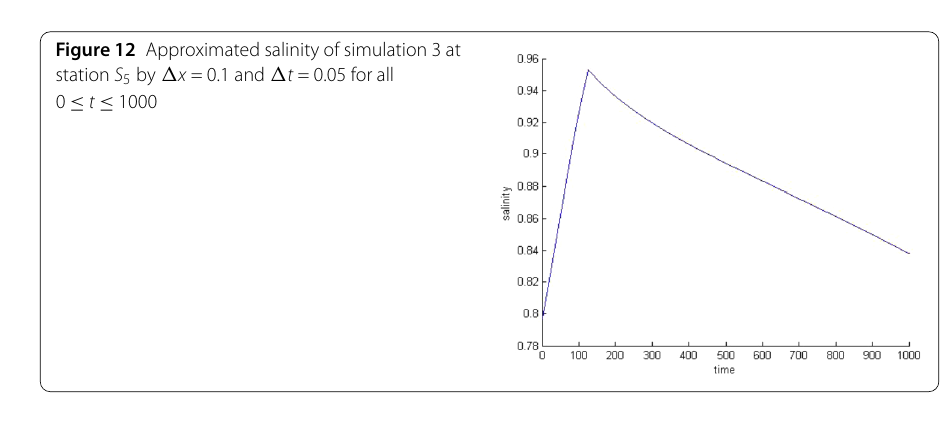
Figure 13 Approximated salinity of simulation 3 at station S 7 by (cid:4) x = 0.1 and (cid:4) t = 0.05 for all 0 ≤ t ≤